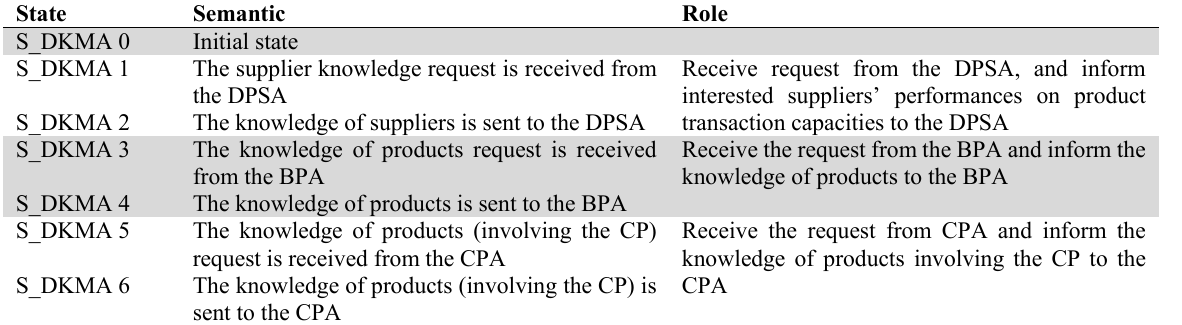
Fig. 3 . State transition diagram of the DKMA The DKMA’s states, their semantics and